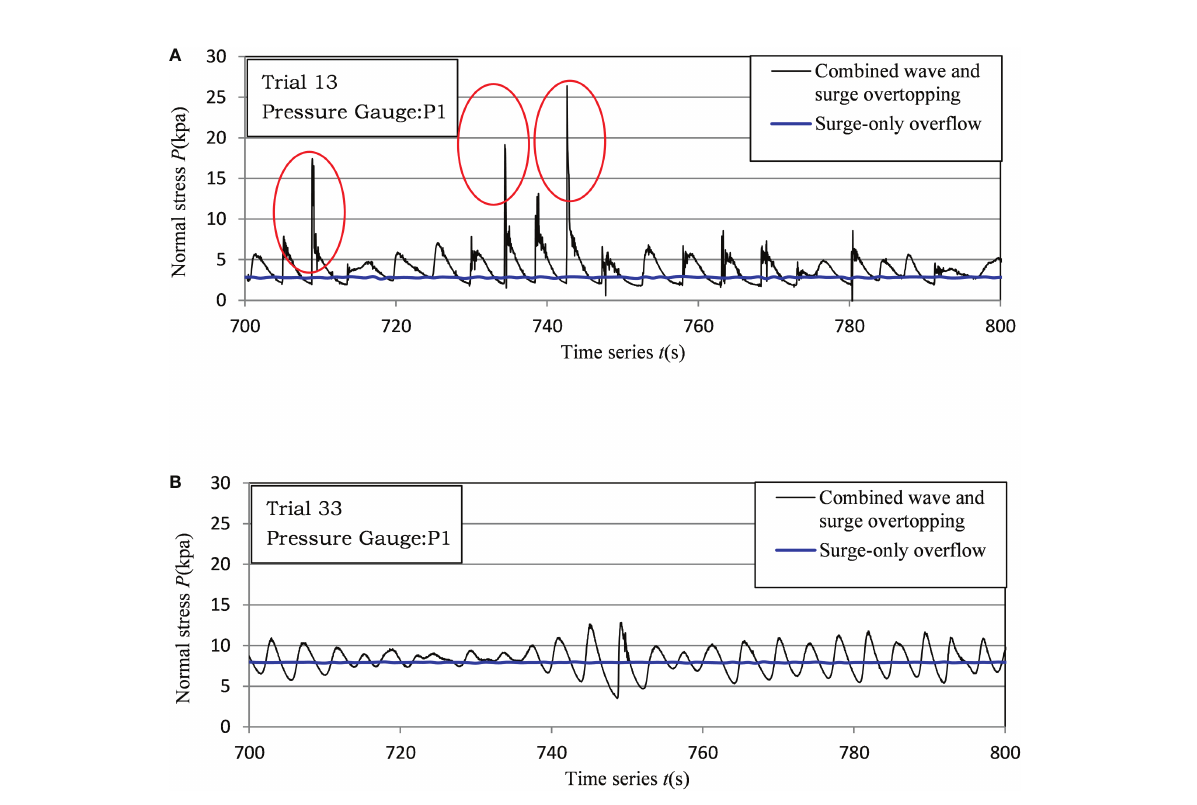
FIGURE 7 Samples of normal stresses time series at P1 on the dike crest: (A) abruptly change; (B) gradually